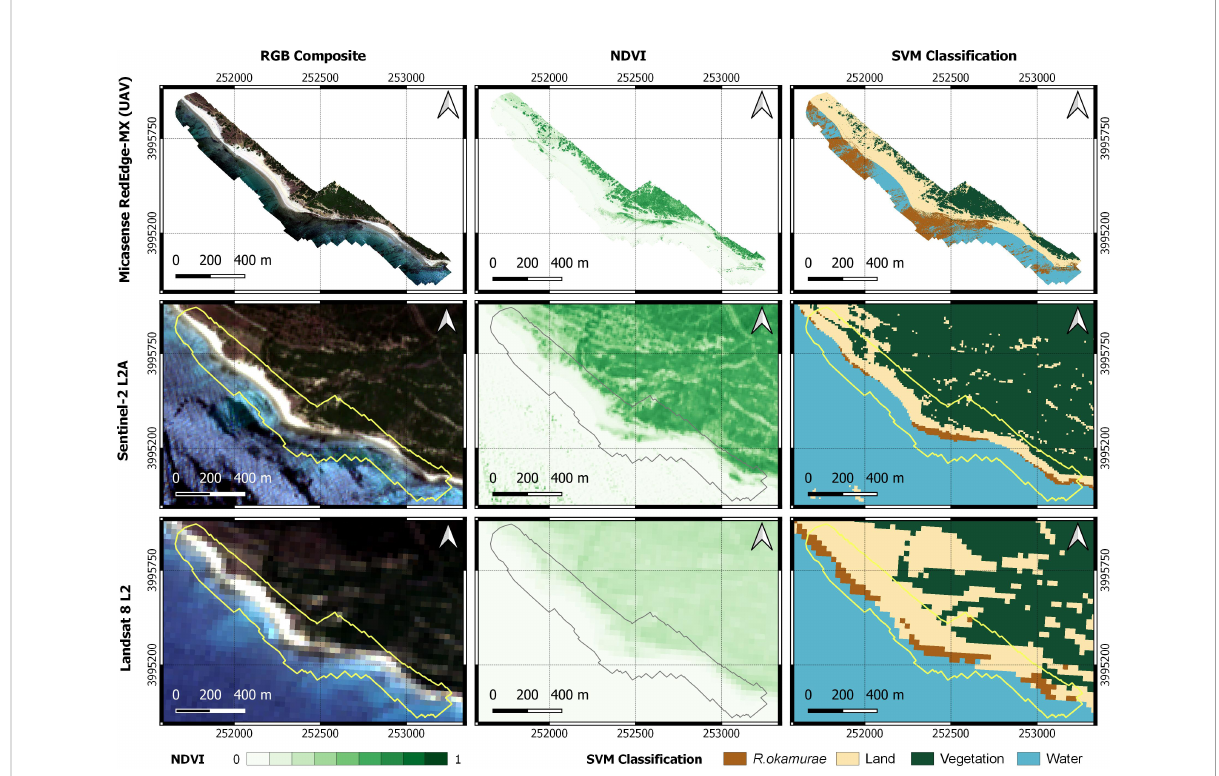
FIGURE 8 Supervised classi fi cation resulting from the application of SVM to re fl ectance data obtained with the multispectral sensor onboard the UAV, S2 and L8, with spatial resolutions of 8 cm, 10 m and 30 m, respectively.